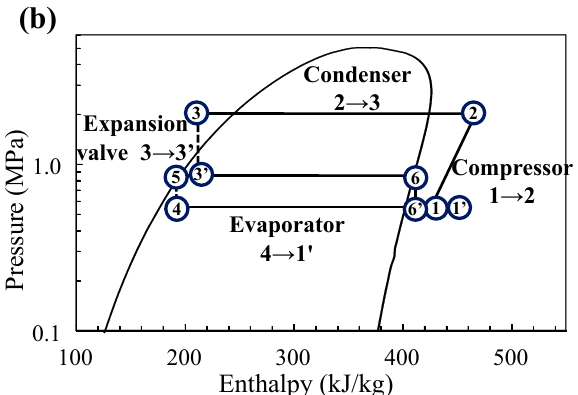
Figure 1. ( a ) The refrigerant cycle of the single-stage heat pump with vapor injection; ( b ) the pressure-enthalpy ( P - h ) diagram of a single-stage heat pump with vapor injection.